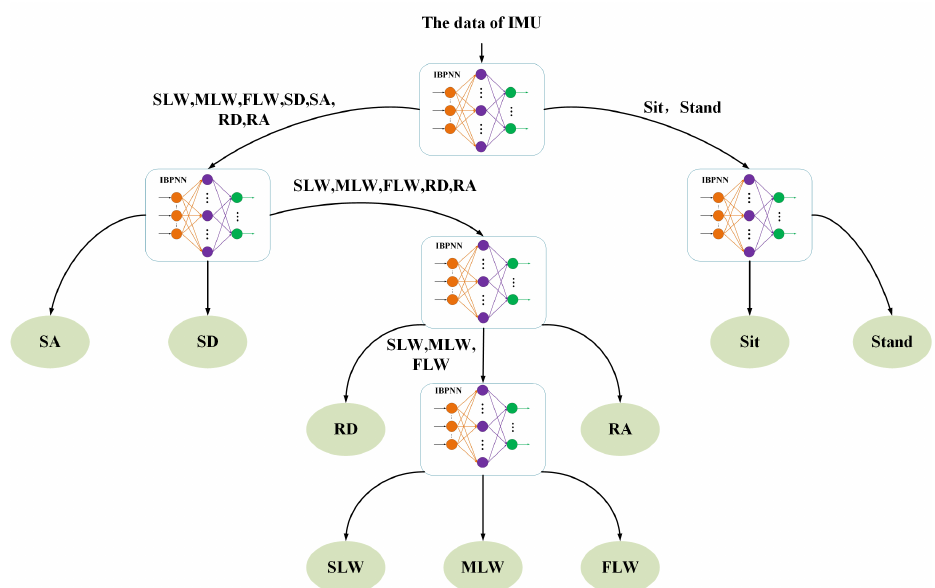
Figure 2. DTS B: four layers and five judgment nodes based on locomotion mode